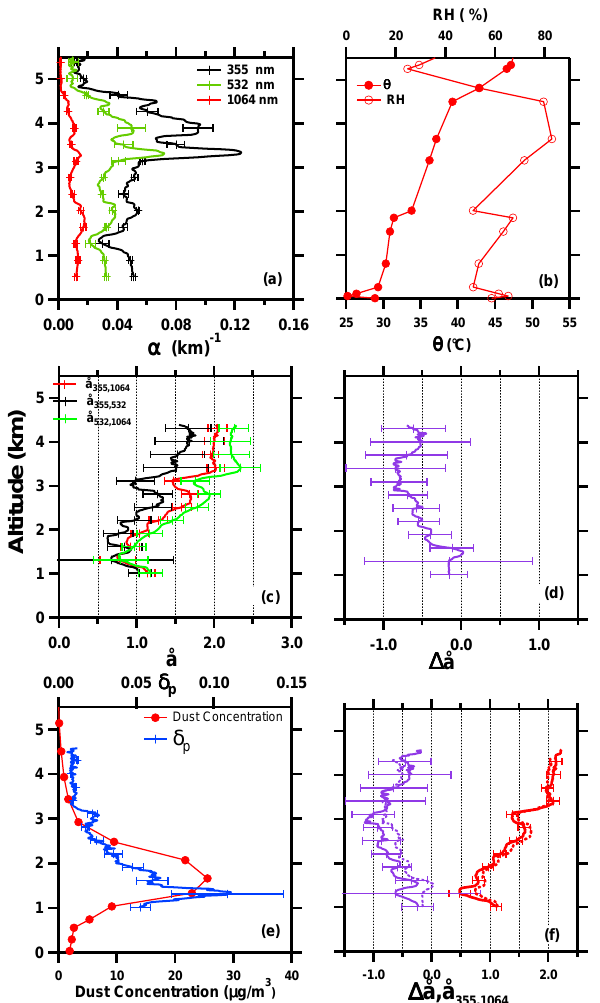
Fig. 2. (a) Extinction coefficient profiles at 355nm (black line), 532nm (green line), and 1064nm (red line) retrieved from li- dar measurements performed on 28 July 2011 from 12:28 to Figure 2 (M. R. Perrone et al.) 5 13:00UTC. (b) Vertical profiles of the potential temperature ( θ ) and relative humidity (RH) retrieved from radio-sounding mea- surements performed at 11:00UTC. Vertical profiles of (c) the Ångstrom exponents å 355 , 532 (z) , å 532 , 1064 (z) , å 355 , 1064 (z) , and (d) the spectral curvature 1 å (z) . (e) Vertical profile of the lin- ear particle depolarization ratio (blue line) with corresponding un- certainties (error bars) and the dust particle concentration from the BSC–DREAM model (red line). (f) Vertical profiles of the Ångstrom exponents å 355 , 1064 (z) and the spectral curvature 1 å (z) calculated from extinction profiles based on altitude-dependent li- dar ratio values. Dotted lines represent the corresponding profiles plotted in Fig. 2c and d,